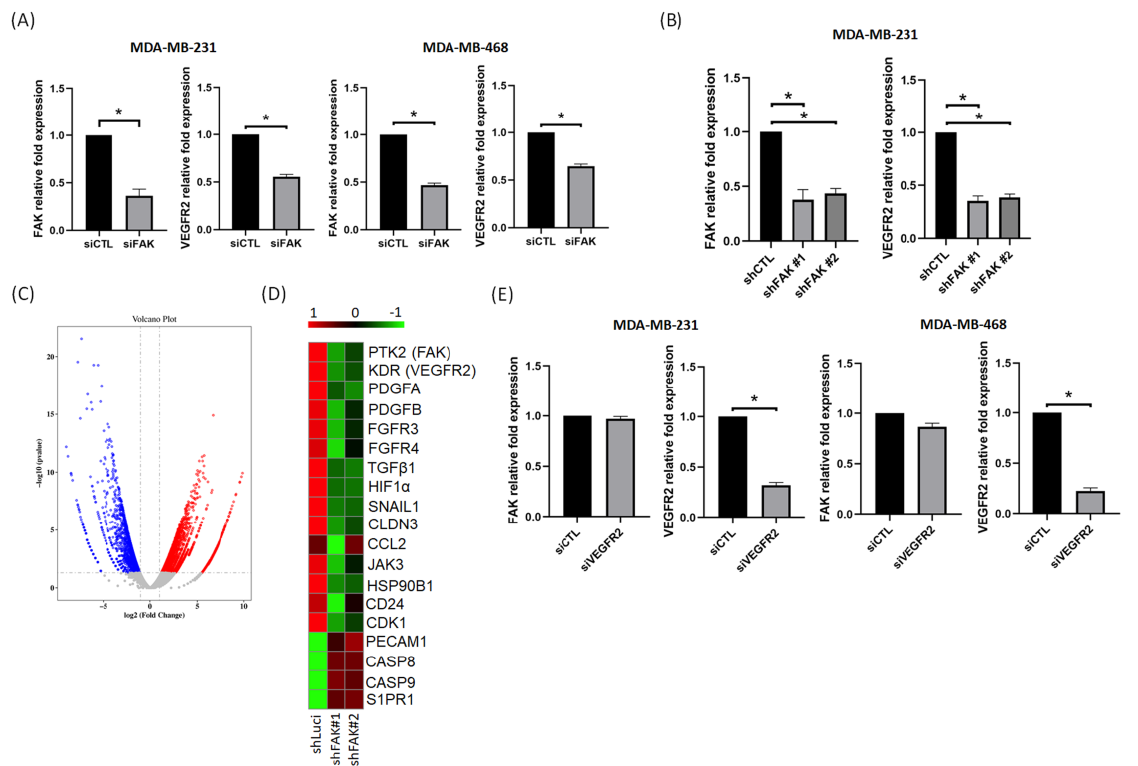
Figure 3. VEGFR2 is regulated through gene expression of FAK in TNBC cells. ( A ) Knockdown of FAK decreased VEGFR2 gene expression in MDA-MB-231 and MDA-MB-468 cells. ( B ) VEGFR2 gene expression decreased in two stable knockdown FAK clones. ( C ) The different gene expressions in shLuci and two shFAK MDA-MB-231 cells from RNA sequencing displayed as a volcano plot. Red marks represent upregulated genes and blue marks represent downregulated genes. ( D ) Heatmap shows that several angiogenic related gene expressions, such as PTK2, KDR, TGF- β 1, HIF-1 α , etc., were reduced significantly in shFAK TNBC cells. ( E ) Knockdown of VEGFR2 expression could not affect FAK gene expression in MDA-MB-231 and MDA-MB-468 cells. Data from three independent experiments were used for statistical analysis and *: p < 0.05.